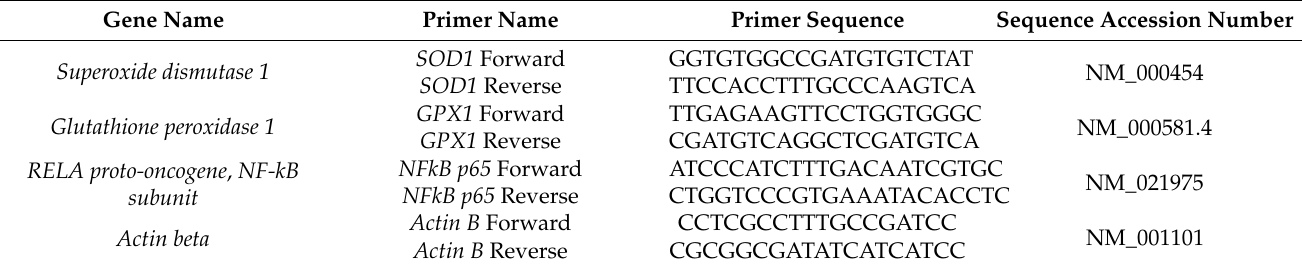
Table 1. Primer sequences used in qRT-PCR